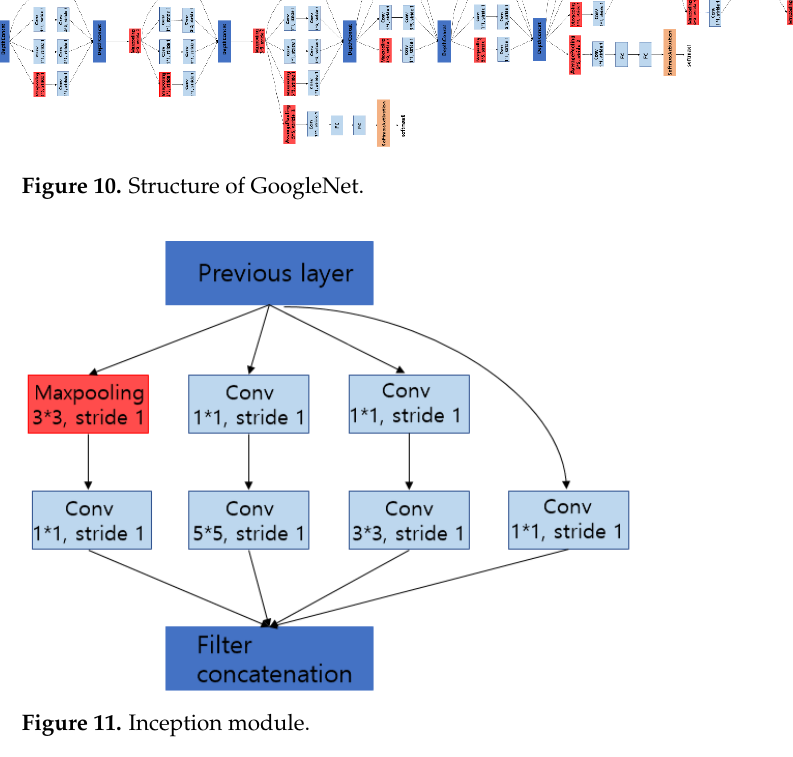
Figure 12. Structure of VGG-19.